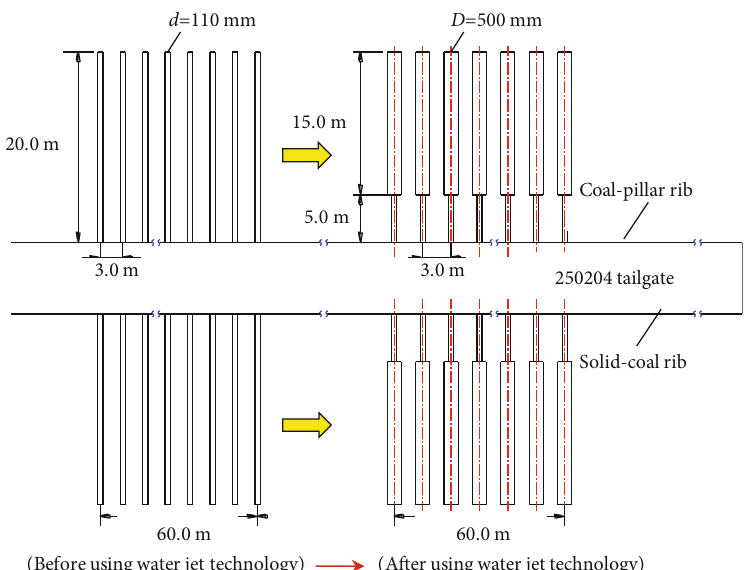
Figure 16: The speci fi c construction scheme of water jet technology in the 250204 tailgate.